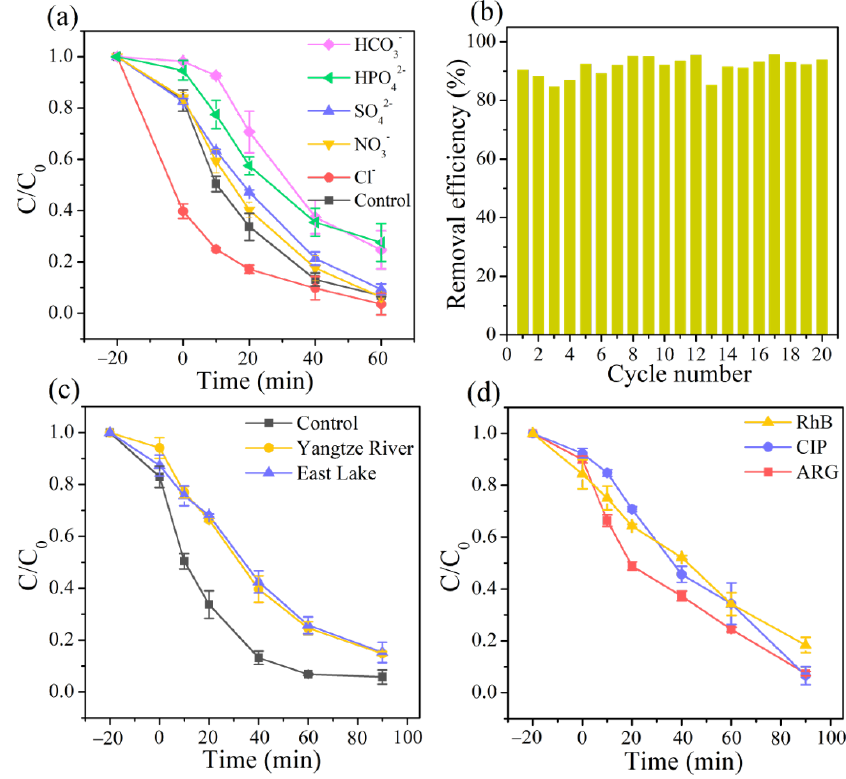
Figure 3. ( a ) Effects of co-existing inorganic anions (10 mM), ( b ) the reusability of the 3DHP-ZVC samples, ( c ) various water systems on the TC removal, and ( d ) degradation of different organic pollutants including RhB, CIP, and ARG.